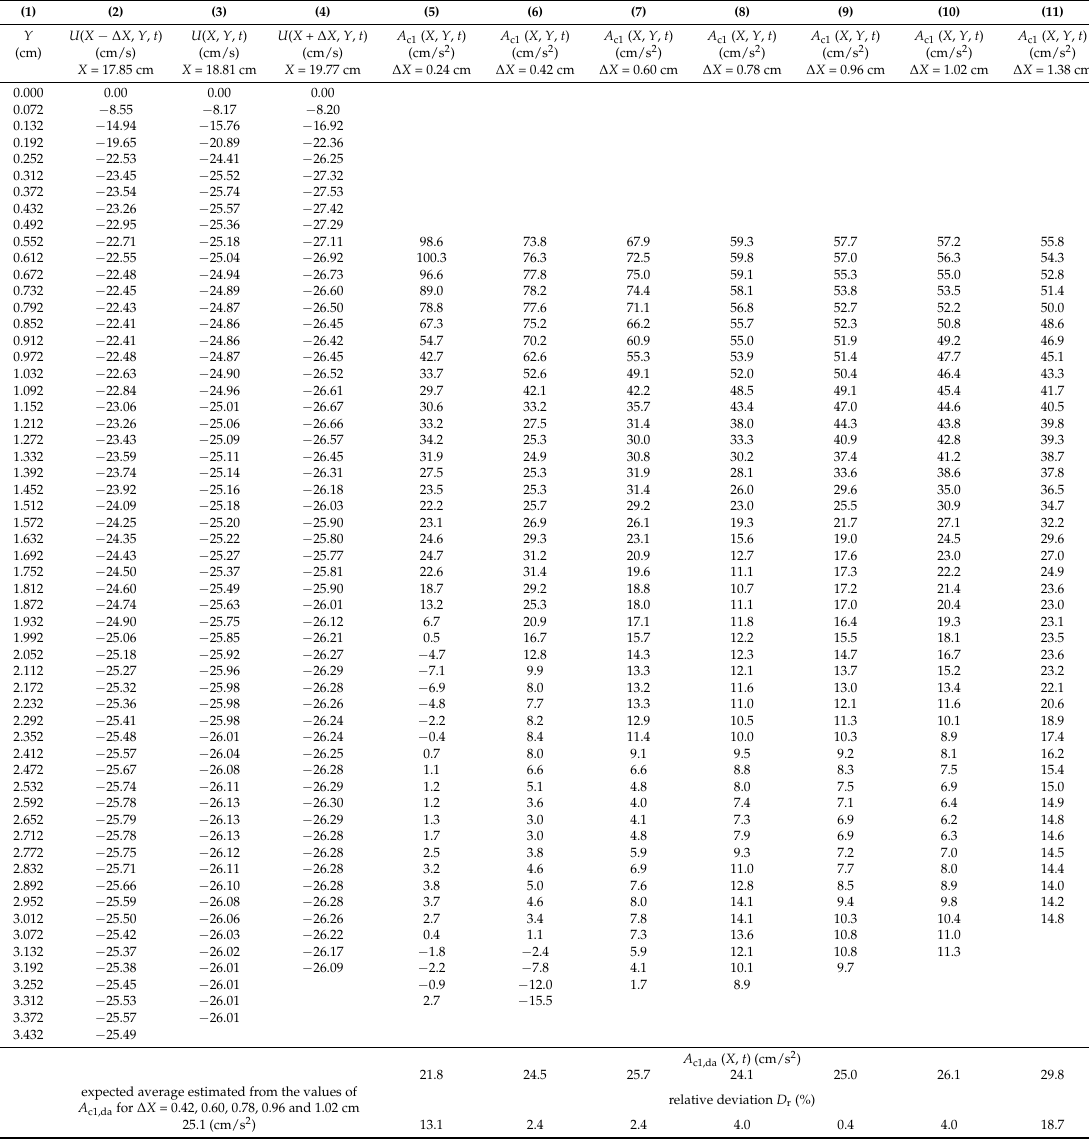
Table A2. A list of velocity data obtained at different sections for T = 7.25 and calculation of the first convective acceleration A c1 with seven distinct spatial intervals, together with the partially depth-averaged values of the first convective acceleration, A c1,da and their relative deviations, D r , presented at the bottom of